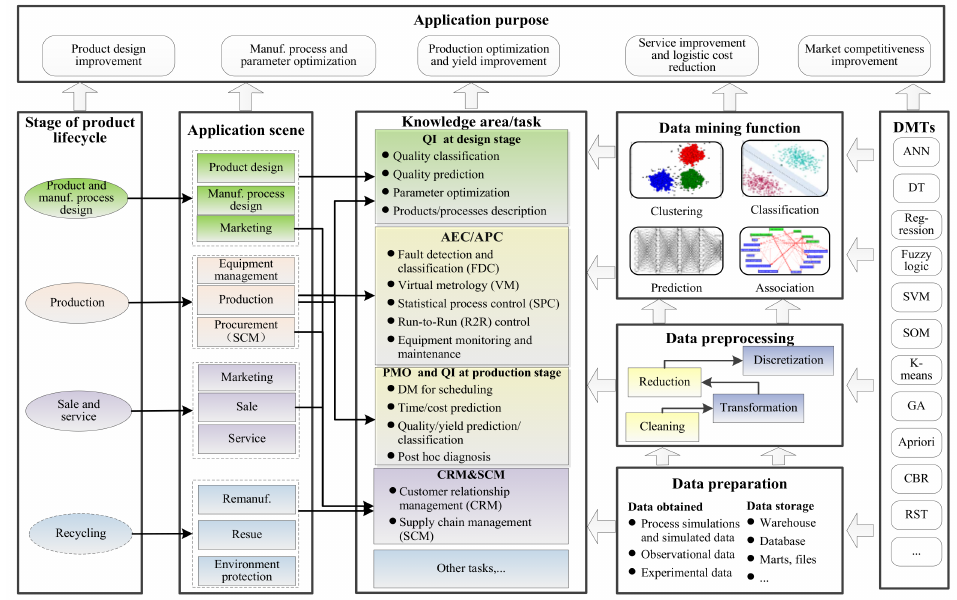
Figure 10. The framework of DM with Big Data towards IT applications in the electronics